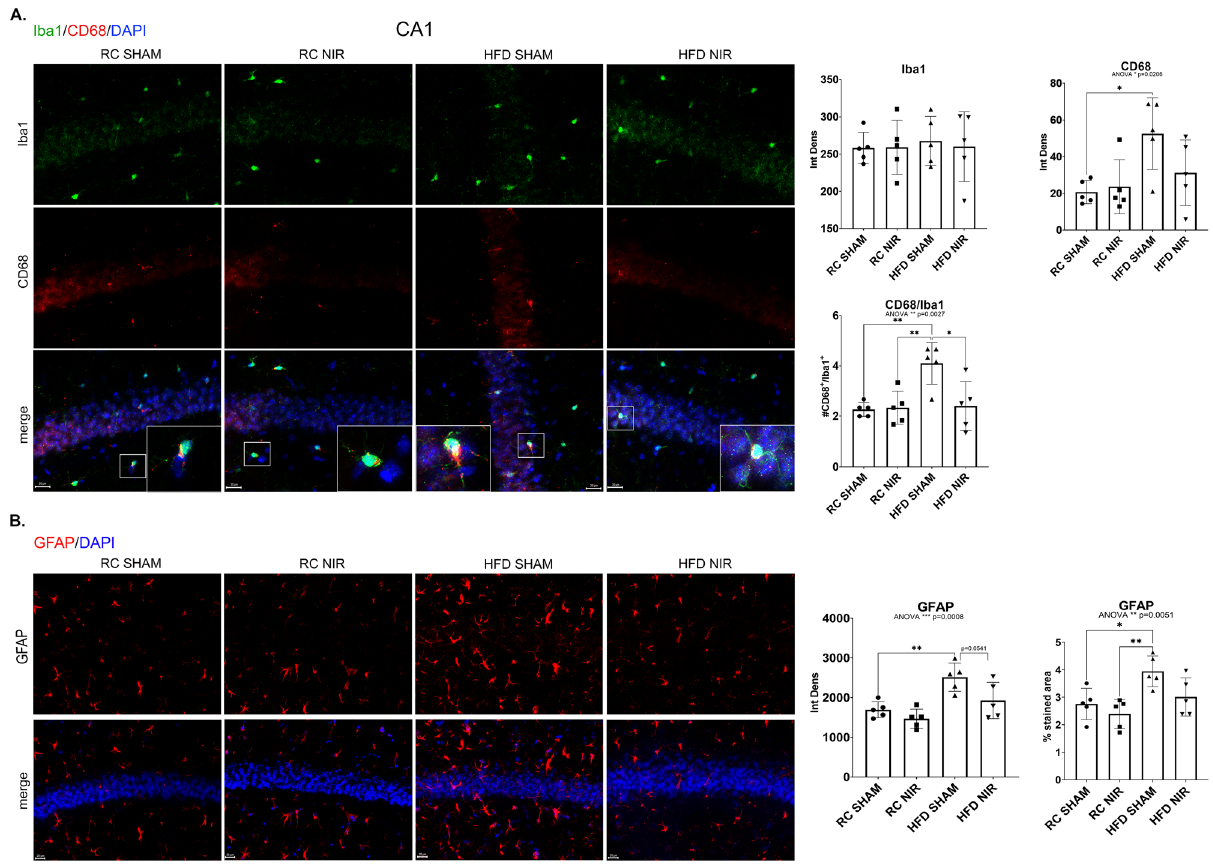
Figure 2. Glia marker expression in the CA1 of RC- and HFD-fed mice with or without NIR. ( A ) Iba-1 levels were similar across groups, while CD68 labeling showed increased microglia activation in the HFD SHAM versus control groups, and decreased levels after NIR treatment. Magnification: 60X. ( B ) GFAP immunoreactivity in the CA1 increased in the HFD regimen mice with respect to RC-fed mice, but this was normalized by NIR ( p = 0.0541). Magnification: 40X. Image results of Z-stacks with pitch of 2.0 μm. n = 5 animals/group. Data are presented as mean ± SD. Each point is the average of 6 images/animal from 2 technical replicates. Statistical analyses: one-way ANOVA with Tukey’s post-hoc test. * p < 0.05, ** p < 0.01. Single images were generated with Keyence BZ-X800 Analyzer (www. keyen ce. com). Graphs were created with GraphPad Prism 8.4.3 and 9.3.1 software (https:// www. graph pad. com/). Images and graphs were composed in Adobe Photoshop 22.2.0 (https:// www. adobe. com/ produ cts/ photo shopf amily.